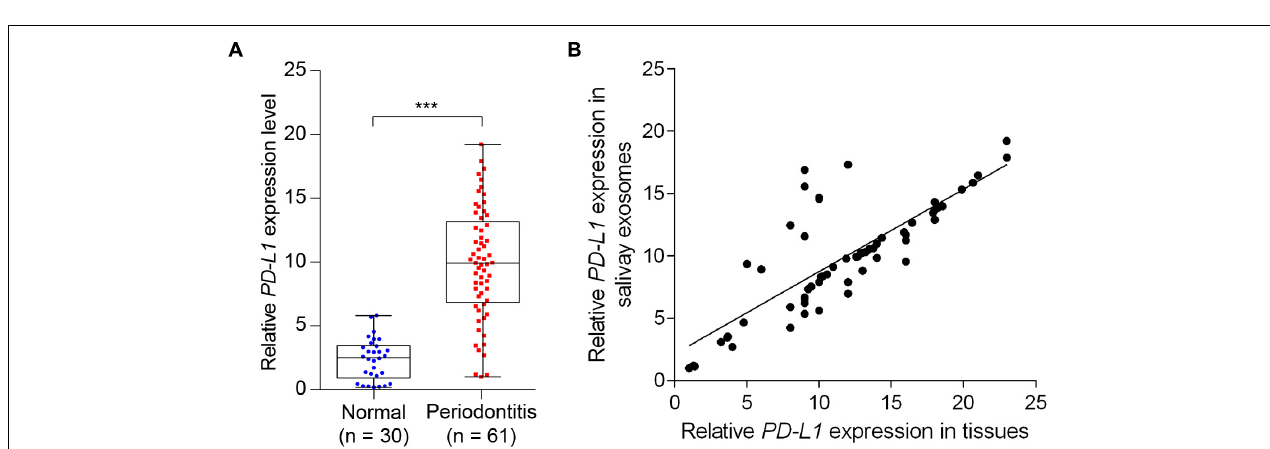
FIGURE 4 | Detection of salivary exosomal PD-L1 in periodontitis patients and normal subjects. (A) Salivary exosomal PD-L1 was measured by RT-qPCR in periodontitis patients ( n = 61) and normal controls ( n = 30). Error bars indicate SEM. ∗∗∗ P < 0.001 by Student’s t- test. (B) Salivary exosomal PD-L1 correlated with periodontal tissue PD-L1 expression in periodontitis patients (Pearson’s correlation